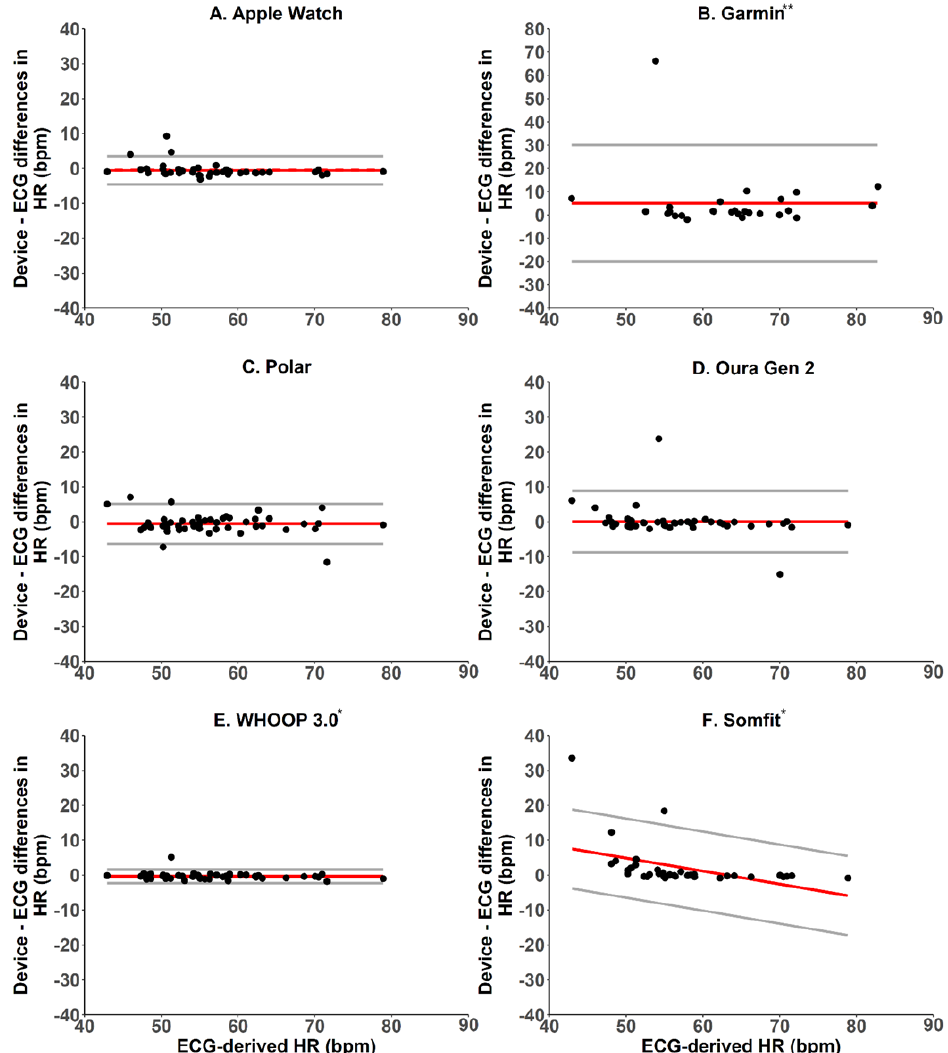
Figure 2. Bland – Altman plots for device – derived and PSG – derived measures of heart rate. The y-axes represent the difference between the measures — positive values indicate devices overestimate relative to PSG, and negative values indicate devices underestimate relative to PSG. Solid red lines indicate the device bias relative to PSG. Solid grey lines indicate the 95% limits of agreement (±1.96 standard deviation). * manufacturers provided raw data; ** y-axis was adjusted in plot B to accommodate for one data point outside of the common y – axis range.